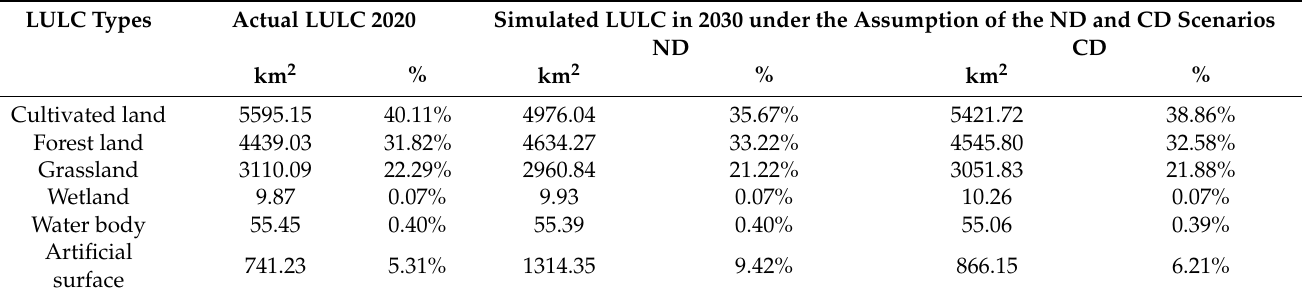
Table 4. Changes in land use and land cover (LULC) between 2020 and 2030 in Changzhi